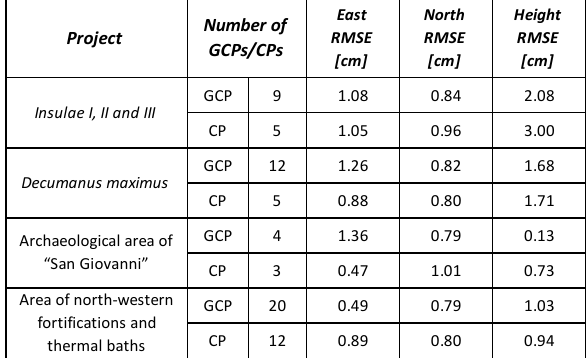
Table 1. RMSE residuals of GCPs and CPs.